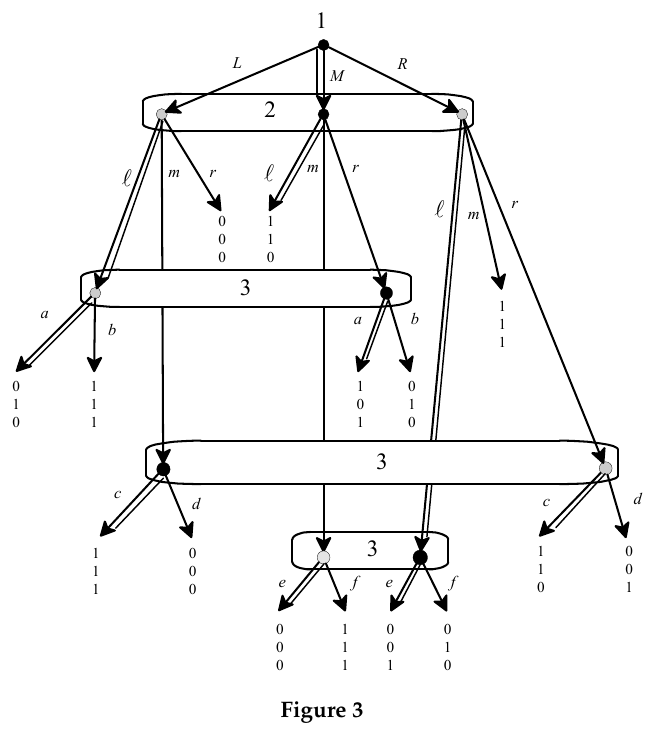
Figure 2 18 . Adding Property IND 2 to the properties given in Definition 8 we obtain a refinement of the notion of weakly independent perfect Bayesian